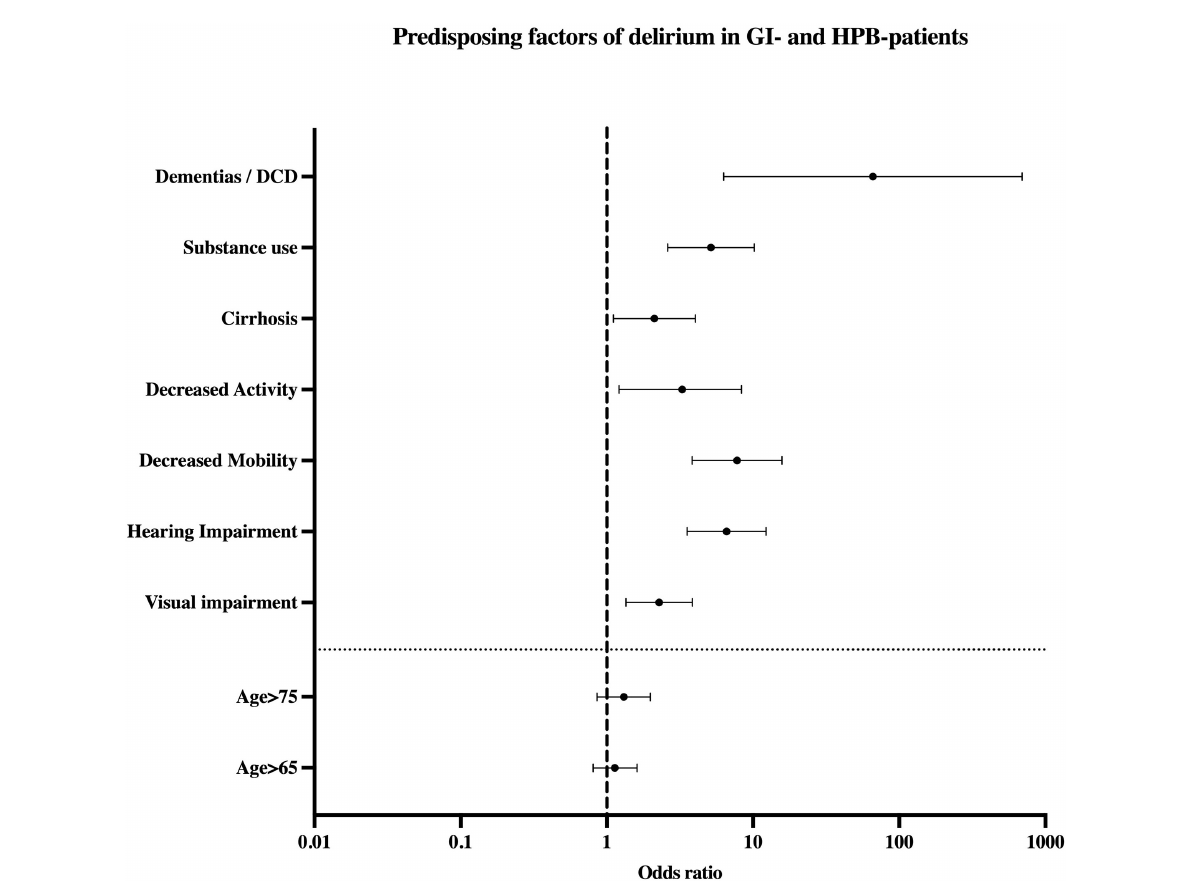
FIGURE3 Predisposing factors of delirium in patients with GI-/HPB-disease. Seven clusters were included in the analysis: three medical (Dementias/DCD, Substance use, Cirrhosis) and four functional (decreased activity, mobility, hearing impairment and visual impairment). Values displayed as Odds ratio. DCD, degenerative cerebral diseases; HPB,